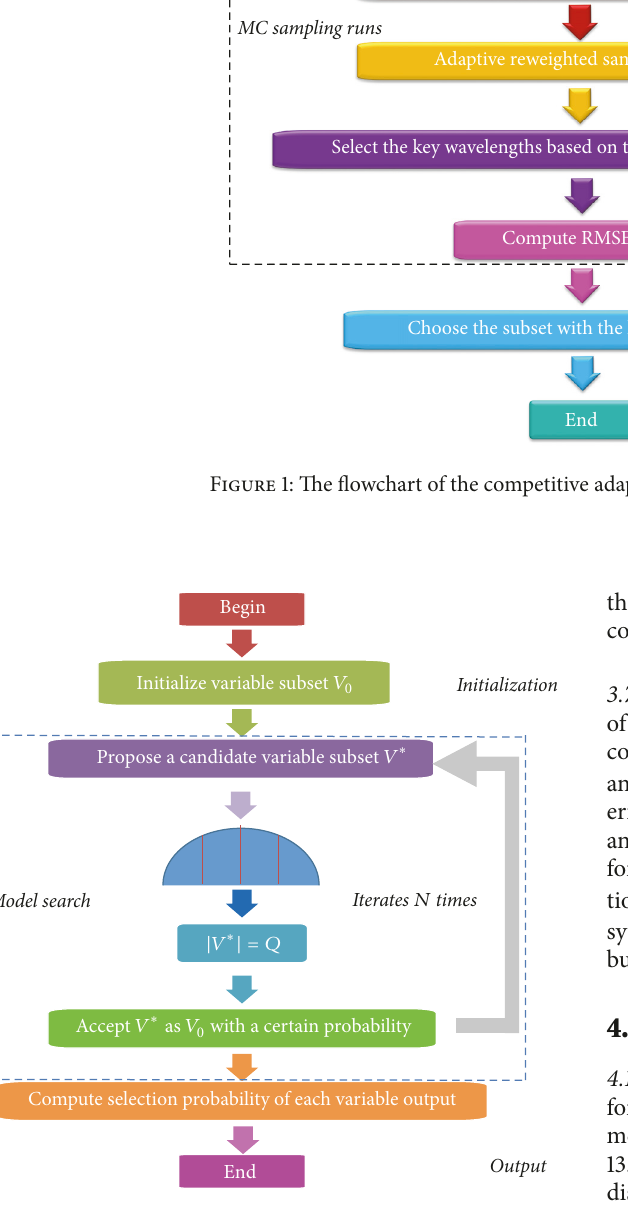
Figure 2: The flowchart of the random frog